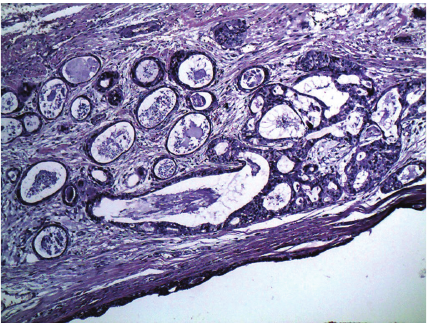
Figure 4: Immunohistochemical examination with 𝛼 SMA con- firmed the presence of a peripheral myoepithelial layer around all ductal structures ( × 400).